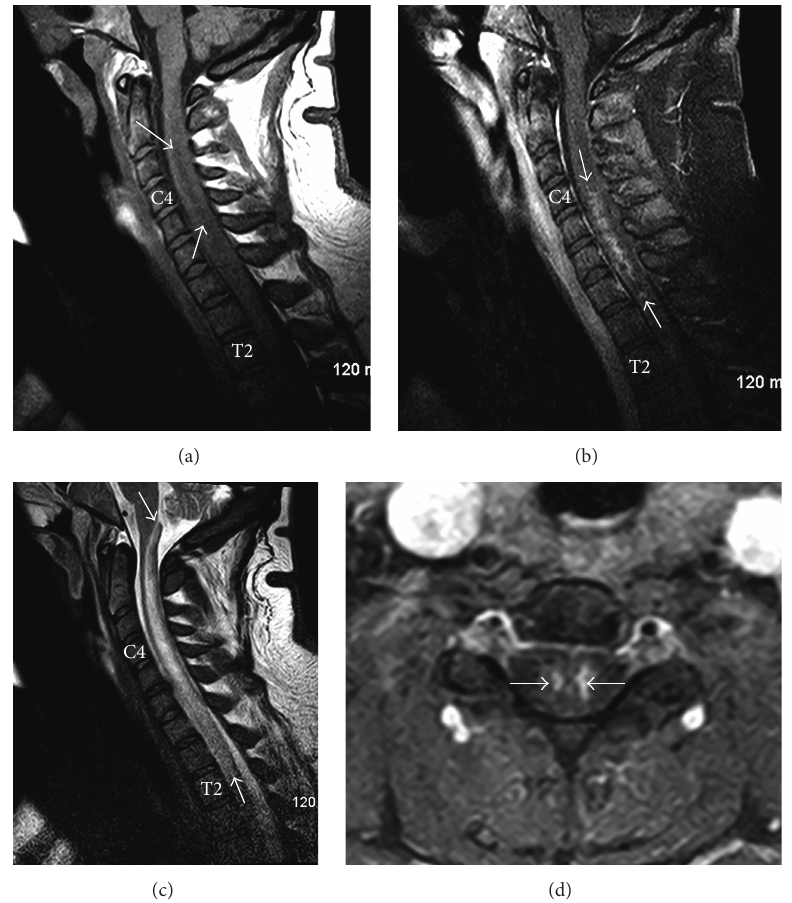
Figure 3: (a) Sagittal T1 weighted FSE image shows superior extension of the spinal cord swelling and abnormal decreased signal intensity centrally (between the white arrows). Note normal signal intensity of the osseous vertebral segments. (b) Sagittal T2 weighted FSE image shows superior extension of the spinal cord swelling and abnormal increased signal intensity centrally (between the white arrows) which now extends to the level of the obex. Note normal signal intensity of the osseous vertebral segments. (c) Sagittal postcontrast T1 weighted FSE image shows patchy enhancement within the central portions of the spinal cord (between the white arrows). (d) Axial postcontrast T1 weighted FSE image at the C4 level shows patchy enhancement confined to the central gray matter of the spinal cord, indicated by the white arrows (more prominent on the viewers